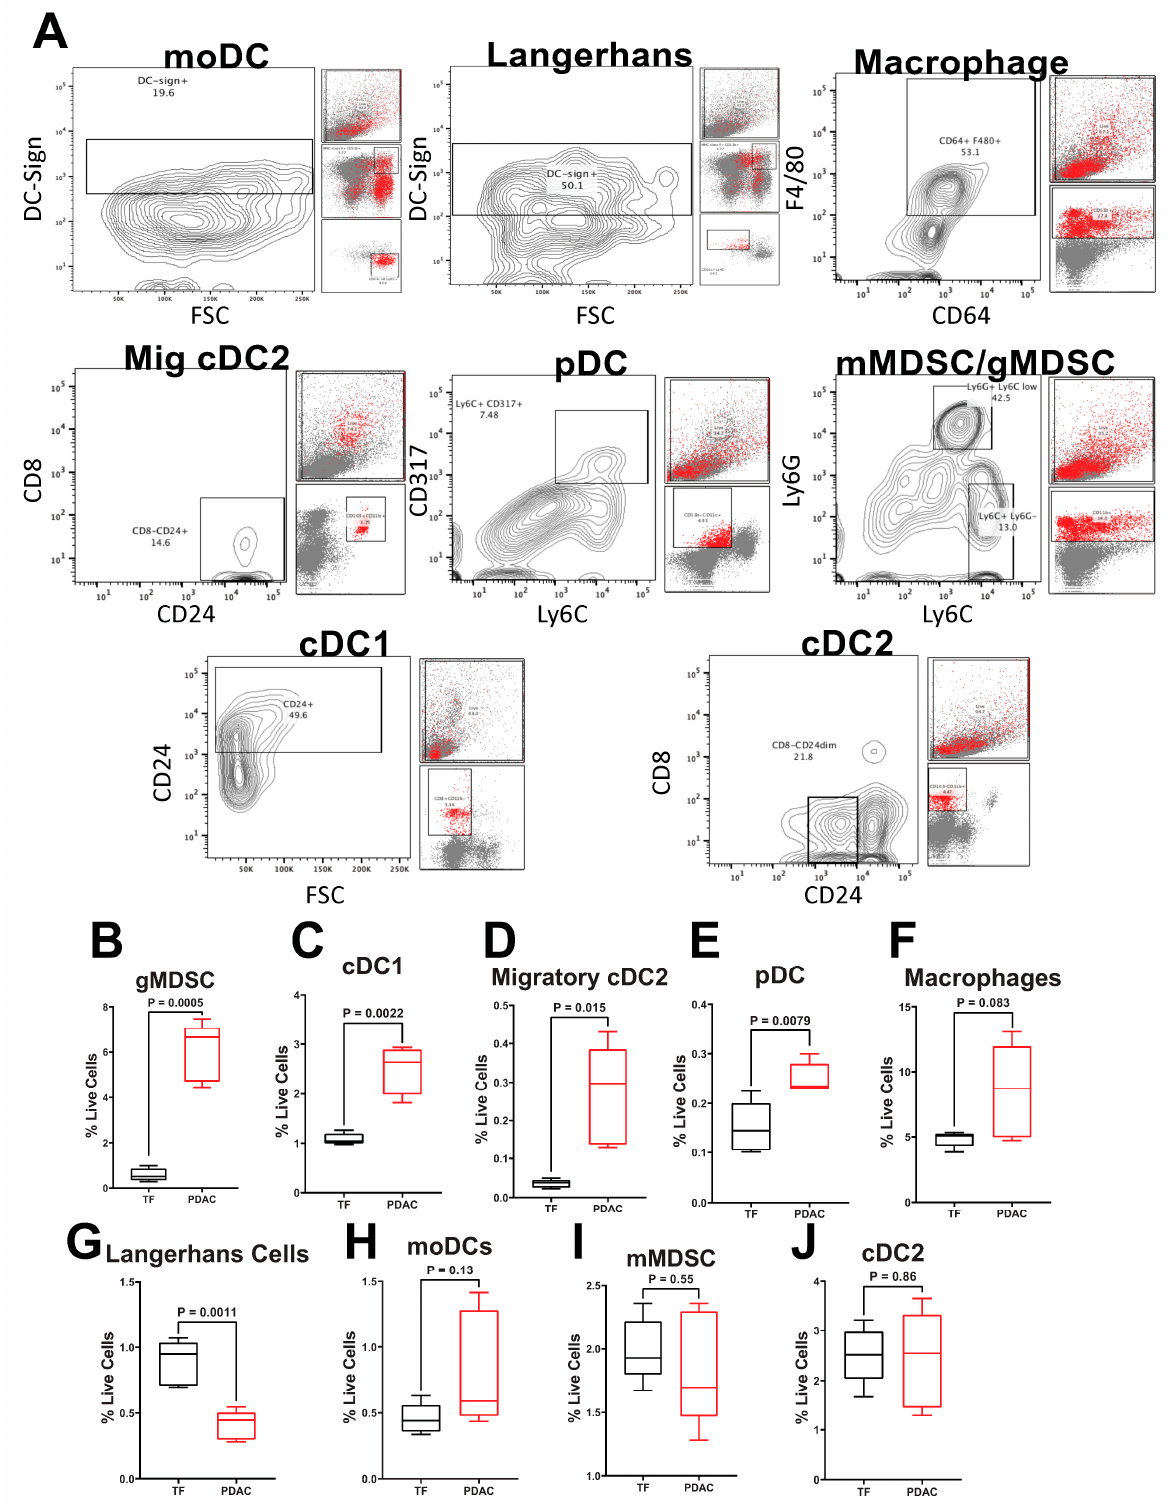
Figure 1. Pancreatic Cancer Alters Murine Splenocyte Immune Populations. Flow cytometry was performed on splenocytes from five different tumor-free (TF) or pancreatic tumor-bearing (PDX-1- Cre, LSL-Kras G12D , LSL-Trp53 − / − ) mice. All tumor-bearing mice were inoculated with tumor cells at the same time. ( A ) Representative contour plots gating for each of the nine populations in